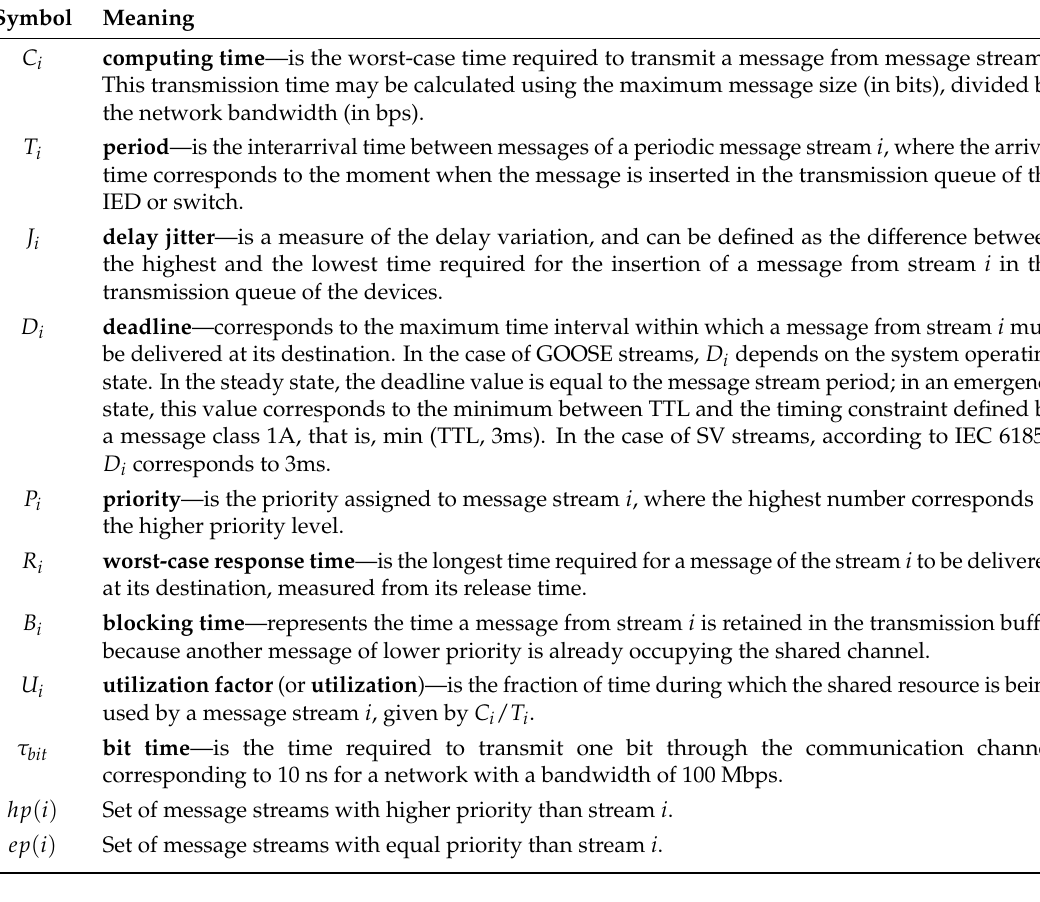
Table 3. Real-time attributes and their notation.